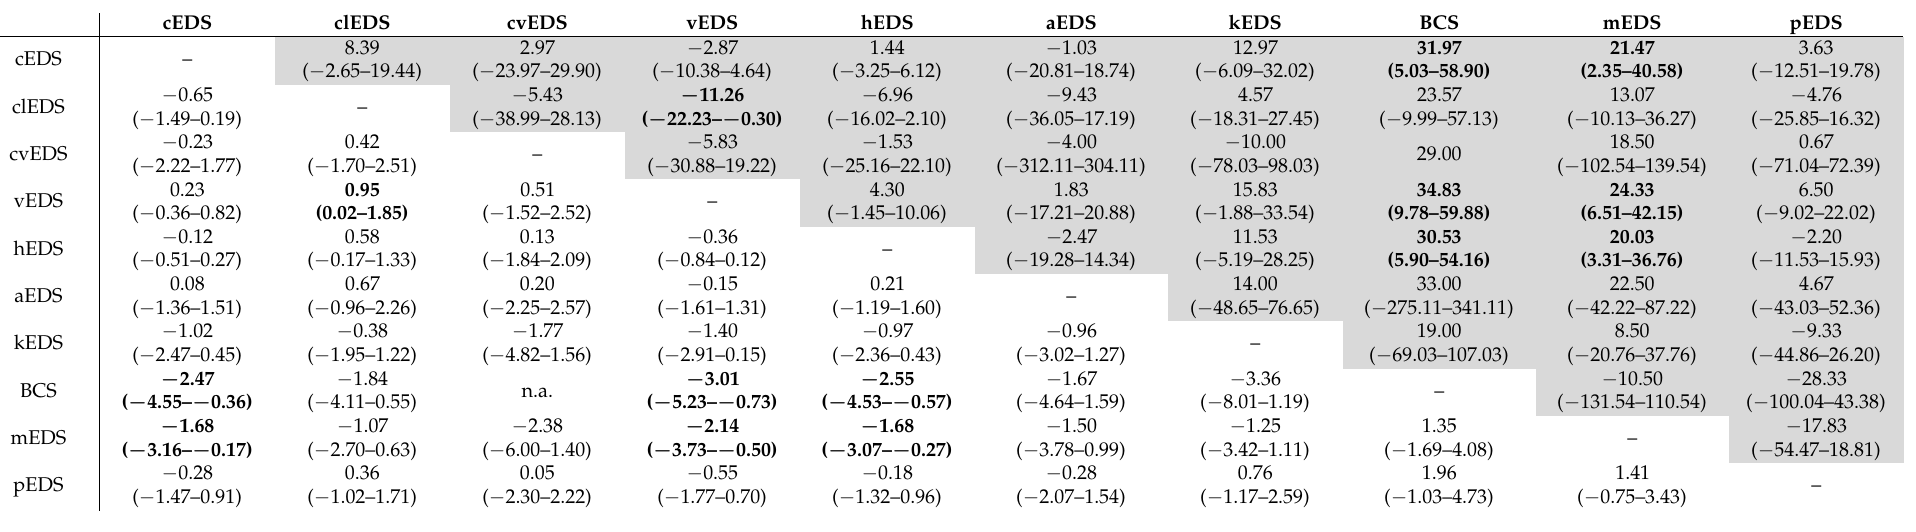
Table 3. Calculated mean differences (95% confidence interval) in Oral Health Impact Profile-Scores (OHIP-G14) are shown in the upper half of the table (shaded gray). Corresponding effect sizes (Cohen’s d; 95% confidence interval) are shown in the lower half of the table (not shaded); significant values are bold; Cohen ´ s d and confidence interval not given for the comparison of cardiac-vascular EDS (cvEDS) and Brittle Cornea Syndrome (BCS), only one participant, respectively; n.a. = not applicable.